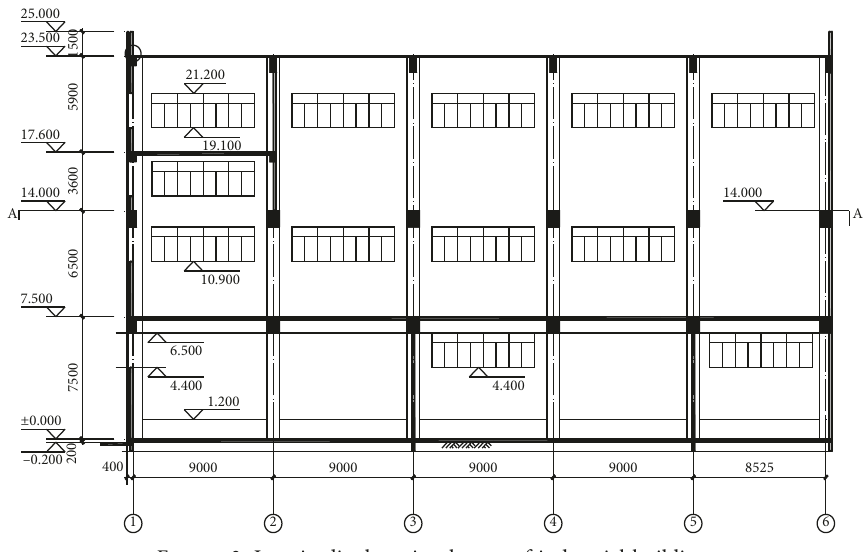
Figure 3: Longitudinal section layout of industrial building.